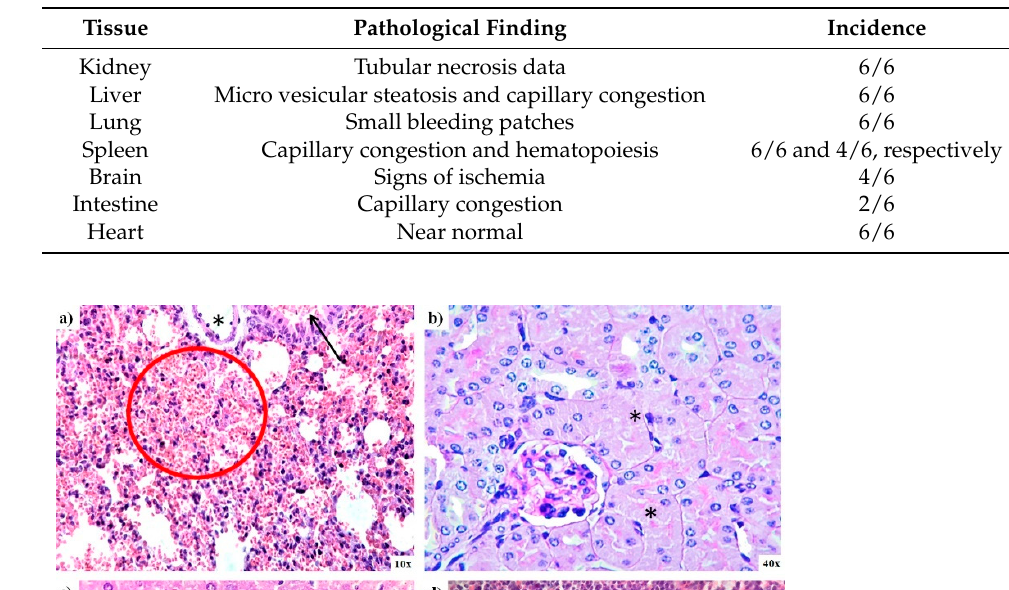
Table 2. Histopathological analysis of kidney, liver, lung, spleen, brain, intestine, and heart of mice exposed to AgNPs.